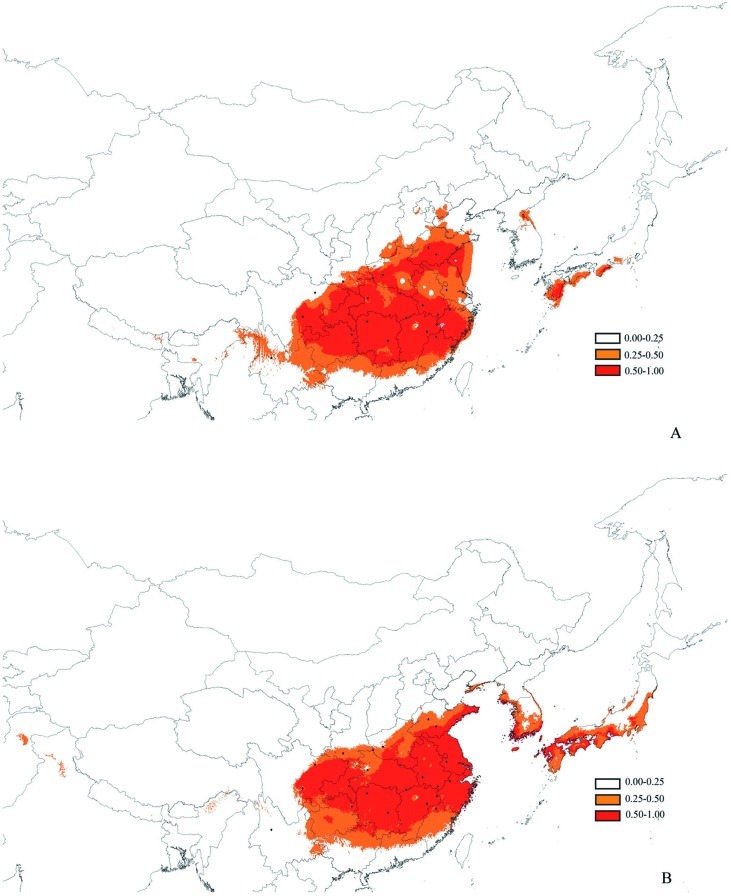
Maps showing potential distribution as a probability of ecological niche modeling with Maxent, distribution maps of Pterocarya stenoptera were yielded by software DIVA-GIS. (Light red, logistic value 0–0.25; Dark red, logistic value 0.5–1). (A) The Last Glacial Maximum, about 21 thousand years ago, (B) the present.